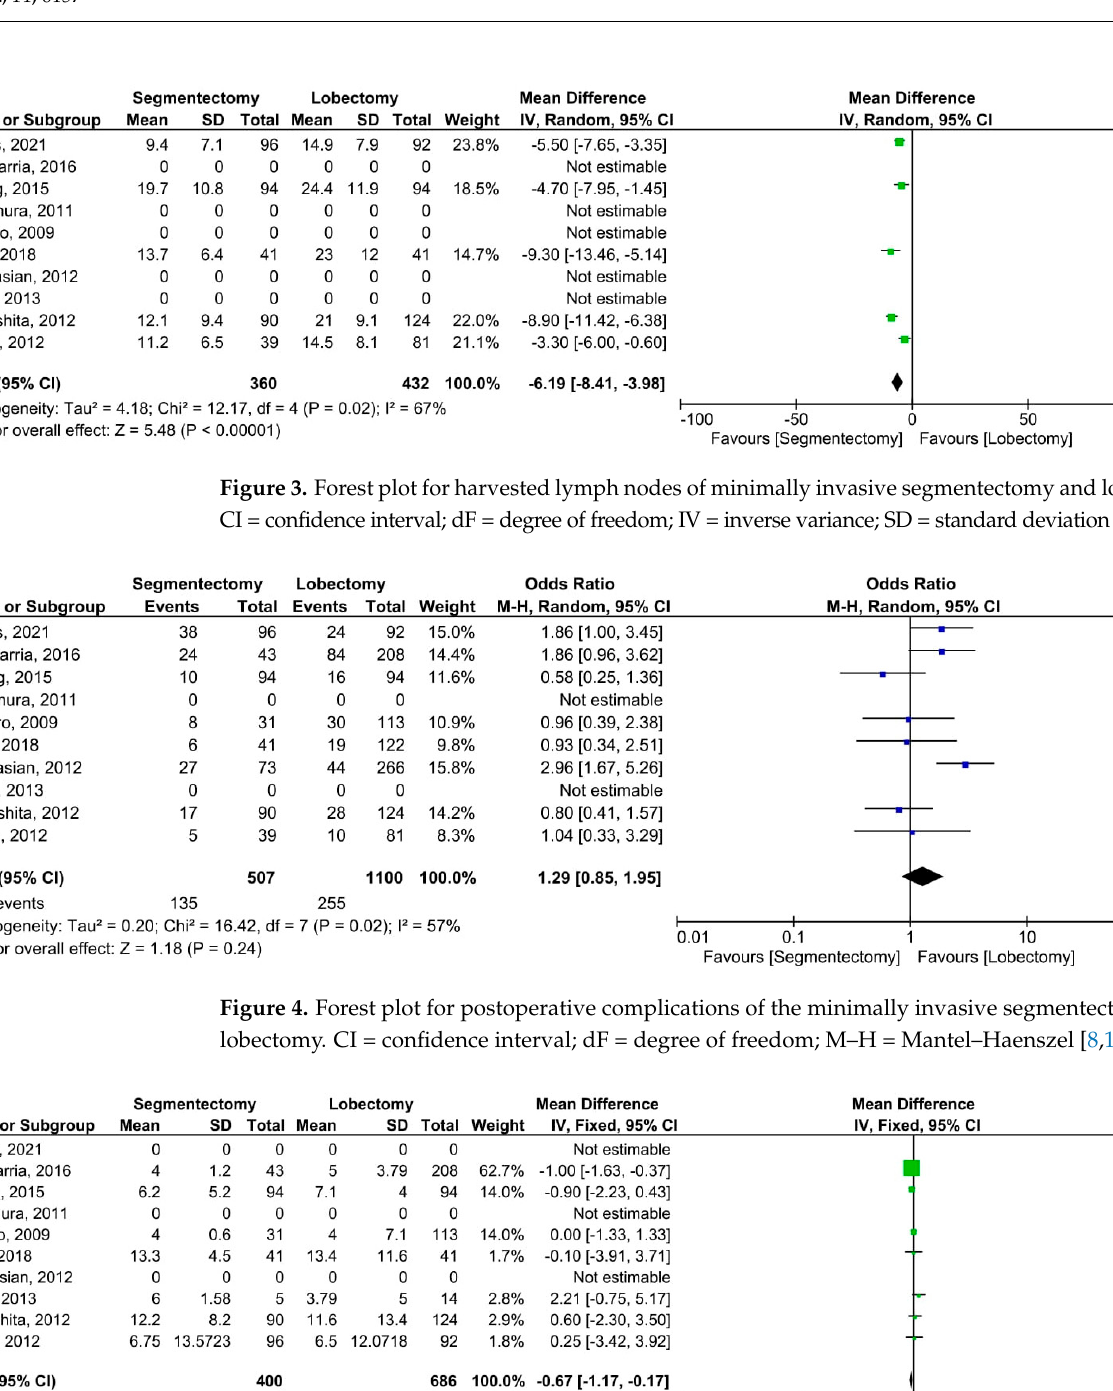
Cancers 2022 , 14 , x 6 of 11 Five articles reported data on harvested lymph nodes and involved 873 patients (360 received segmentectomies and 513 lobectomies). Significant heterogeneity among the studies was demonstrated ( I 2 = 67%, p = 0.02). A significantly higher number of lymph nodes was harvested in minimally invasive lobectomies (MD = − 6.19, 95% CI: − 8.41– − 3.98, p < 0.00,001, Figure 3). Eight articles including 1607 individuals published data on postop ‐ erative complications (507 minimally invasive segmentectomies and 1100 lobectomies). Significant heterogeneity was observed among the studies ( I 2 = 57%, p = 0.02). The inci ‐ dence of postoperative complications did not change substantially between the two groups (OR = 1.29, 95% confidence interval: 0.85–1.95, p = 0.24, Figure 4). Seven publica ‐ tions with 1099 individuals published data on postoperative hospital stay (343 minimally invasive segmentectomies and 756 lobectomies). The studies found no significant hetero ‐